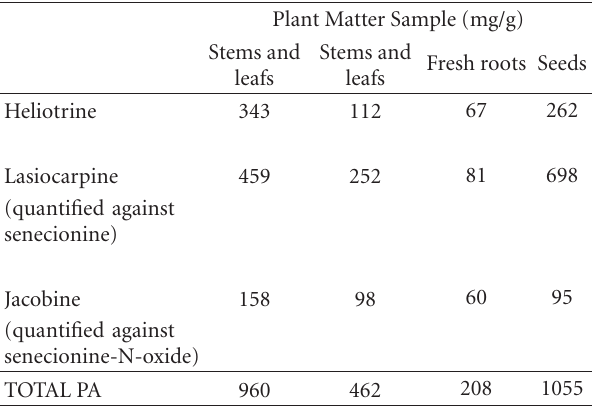
Table 5: PA content of four specimens of charmac plant matter collected from a ff ected villages, Gulran District, Afghanistan, 2008. Plant Matter Sample